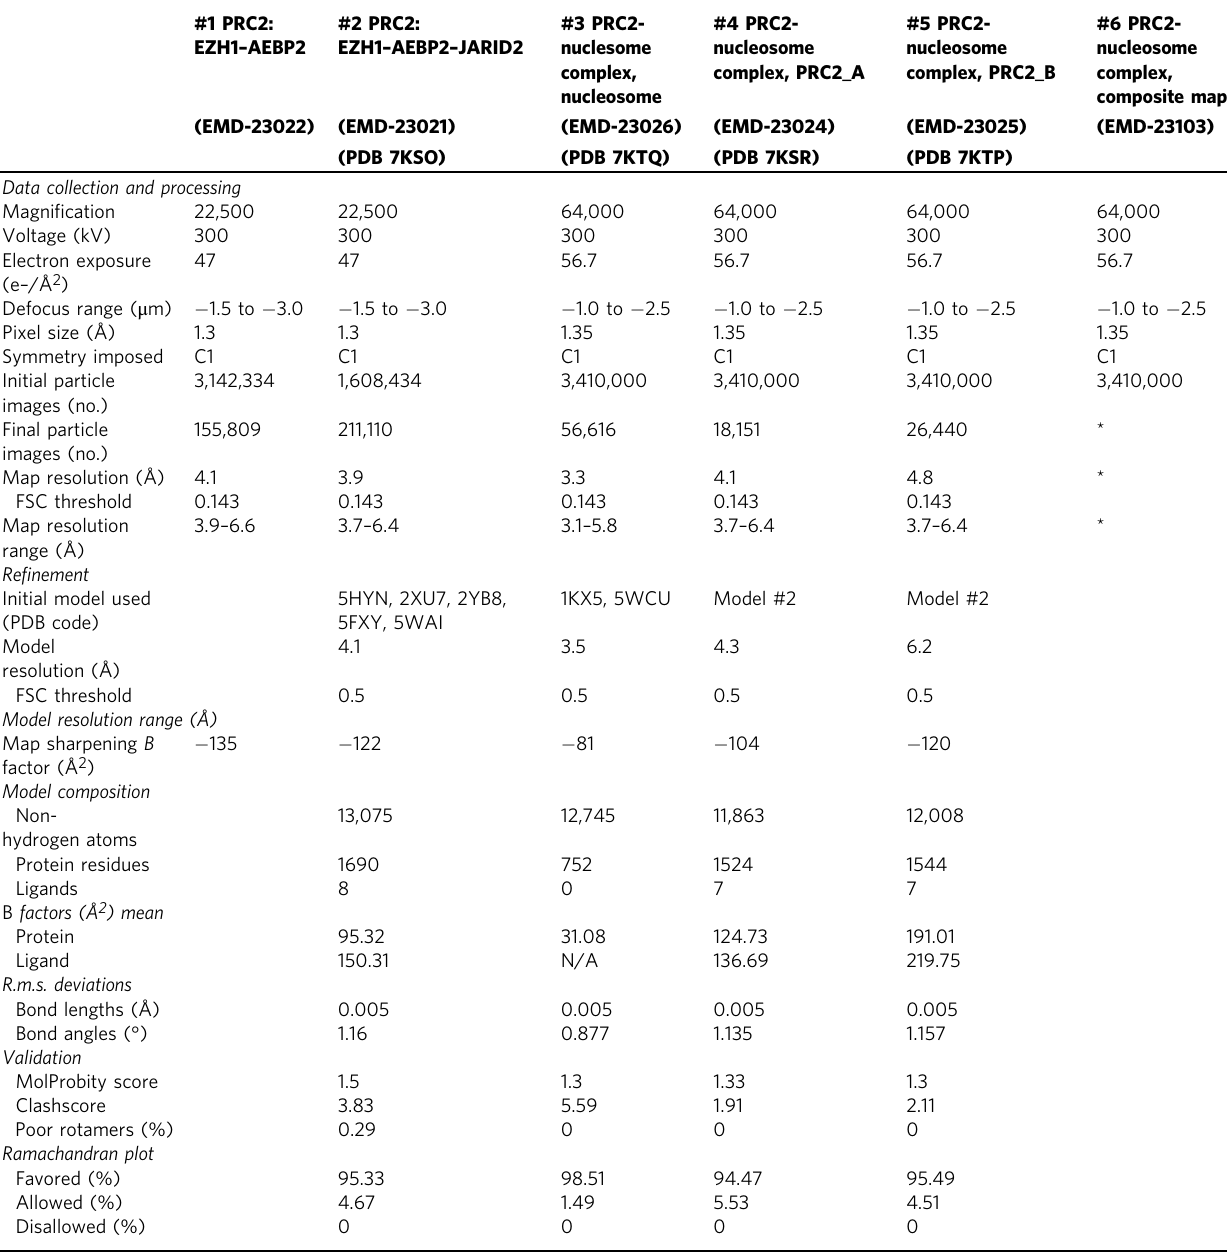
* Composite map comprised of #3 – 5, see individual maps for